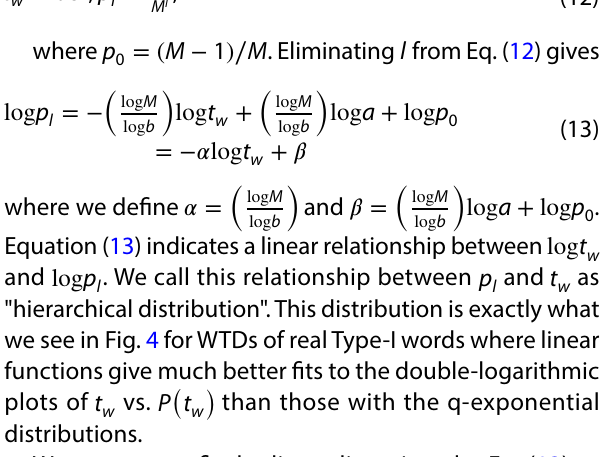
shown in Fig. 5, are also included. BICs corresponding to each of the fittings using the q-exponential distribution, Eq. (4), and the hierarchical distributions, Eq. (13), are also shown as BIC(q-exp) and BIC(hier), respectively